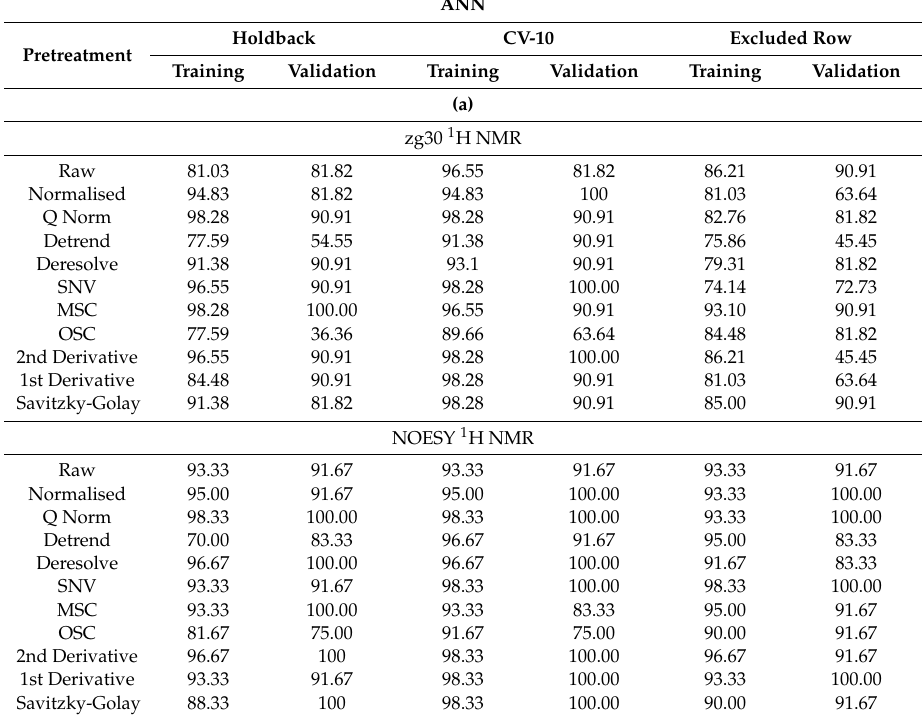
Table 4. Application of artificial neural network (ANN) on the ( a ) 1 H NMR and ( b ) 13 C NMR data using three forms of